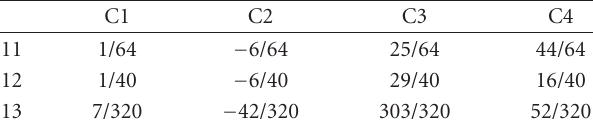
Table 2: Coe ffi cients of 4-tap SPLINE FIR